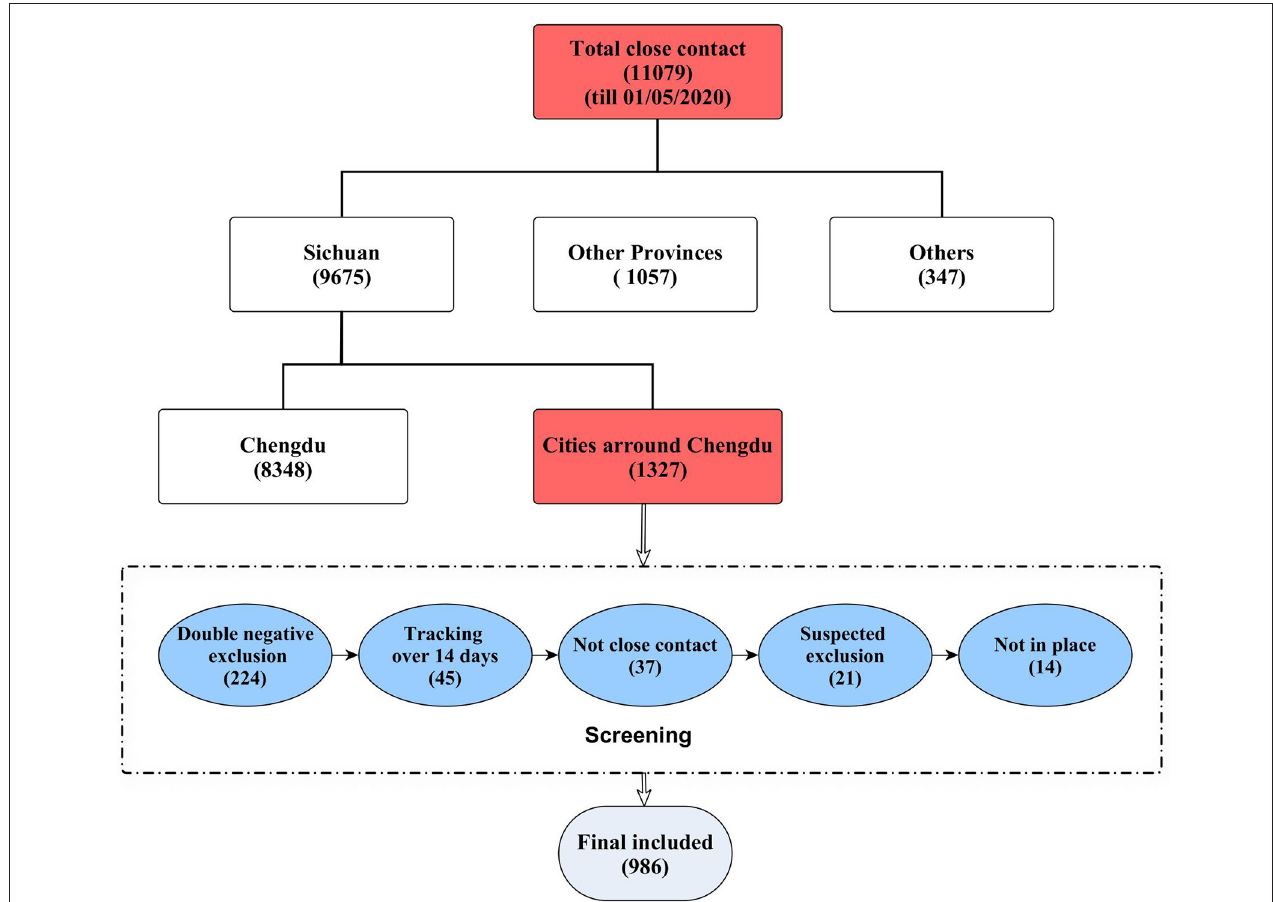
FIGURE 1 | The flow chart of close contact screening.